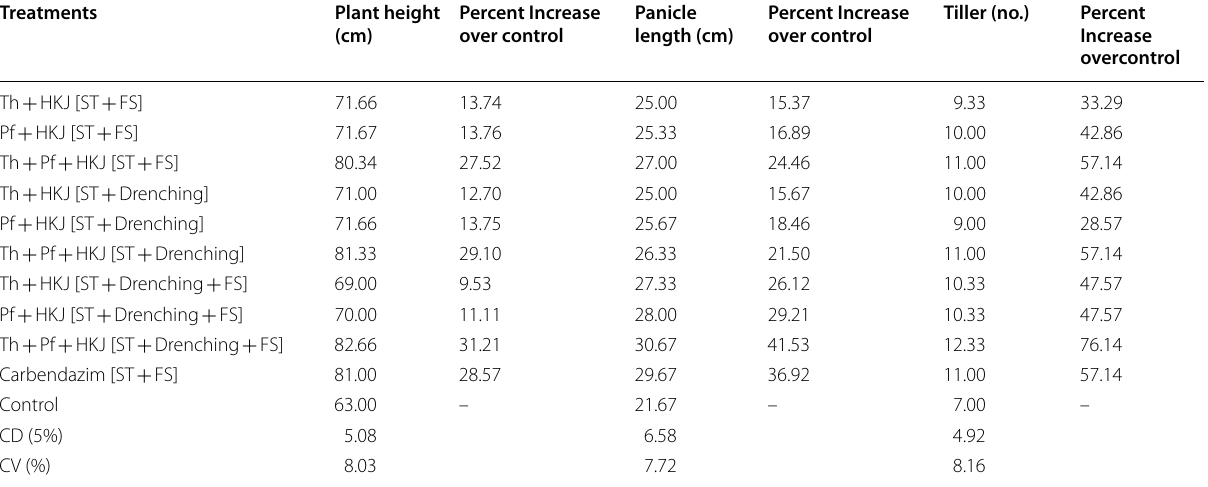
Table 3 Effect of different treatments of Trichoderma harzianum (47), PF Plant vigor at experimental